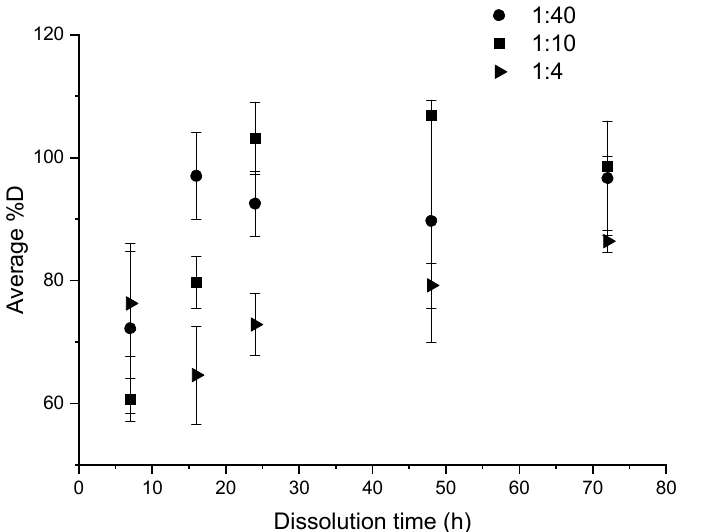
Figure 6. Influence of “composite:acetone” ratio on the average % D as a function of dissolution time for ultrasound at the end of dissolution.